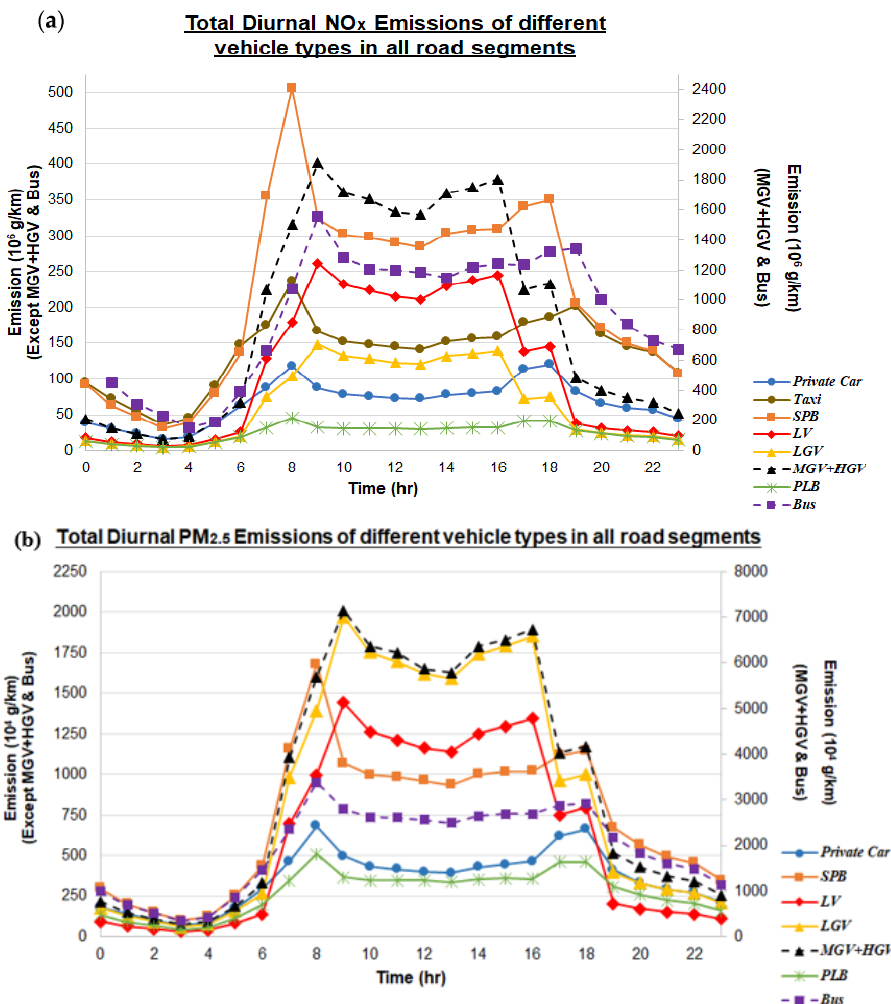
Figure 5. Diurnal Trends of ( a ) NO x (10 6 g/km) and ( b ) PM 2.5 (10 4 g/km) emissions observed for eight vehicle types within 2015 at all road segments with available traffic emission records. The right color bar is applicable for MGV + HGV and bus, while other six vehicle types adopt the color bar on the left side.